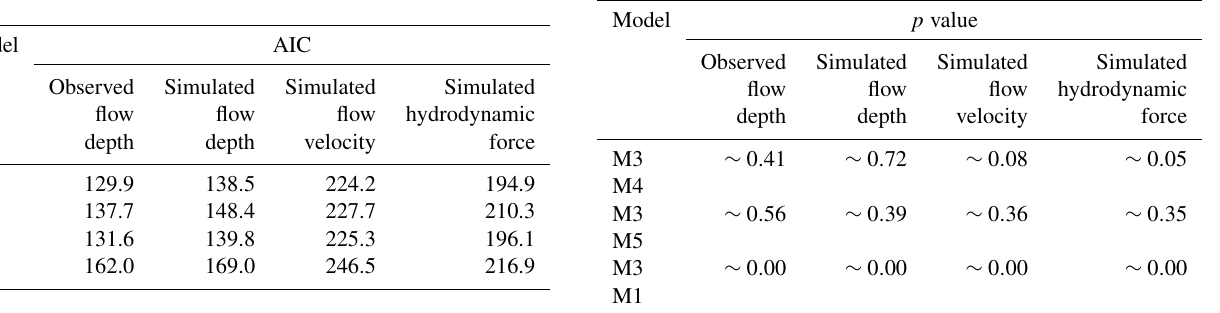
Table 6. AIC values for the three models assuming probit link func- tion fitted to the observed and simulated tsunami intensity measures of DB_Sunda2018.